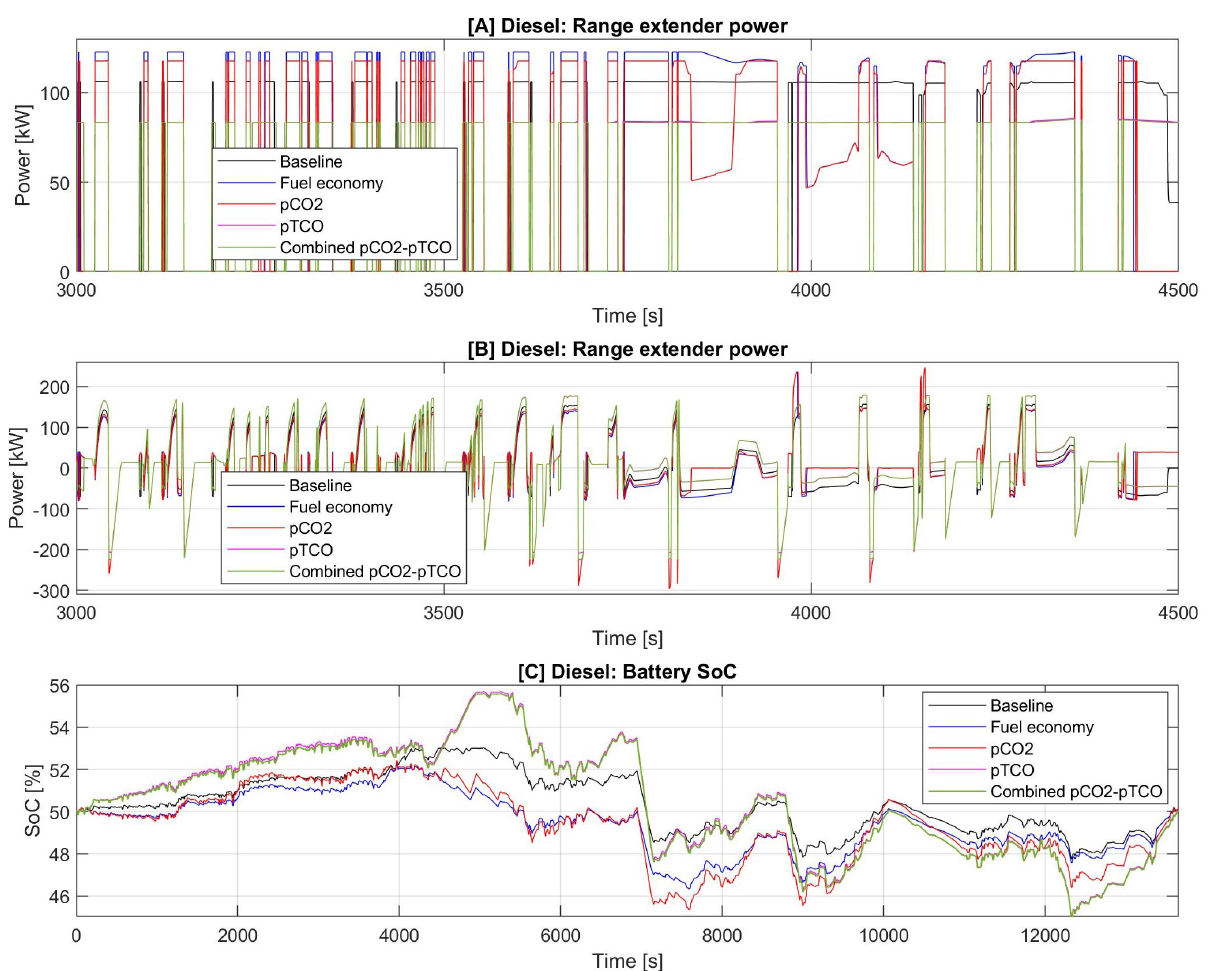
Figure 11. Comparison of ( A ) range extender power output, ( B ) battery power draw and ( C ) SoC variation for various diesel fueled sizing solutions. Range extender, battery and eDrive size varied for different solutions as seen in Section